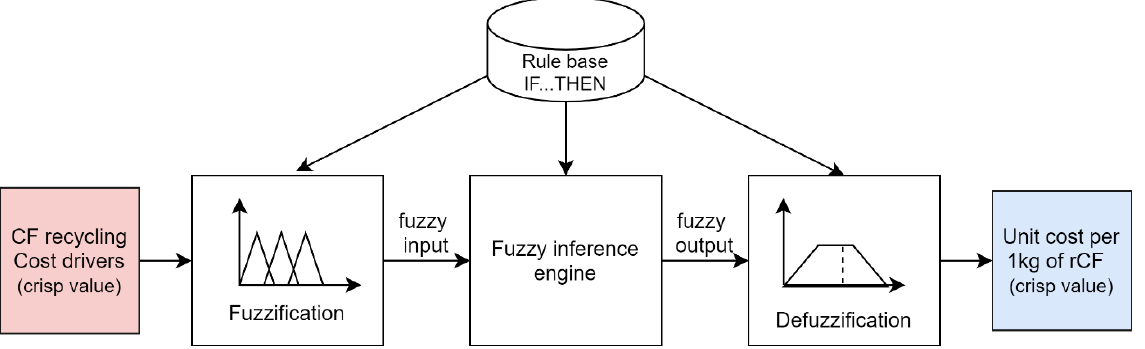
Figure 4. The overall strucutre of the fuzzy logic cost estimation.